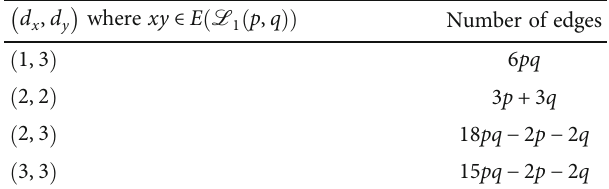
p , q Þ depending on degrees of 1 ð